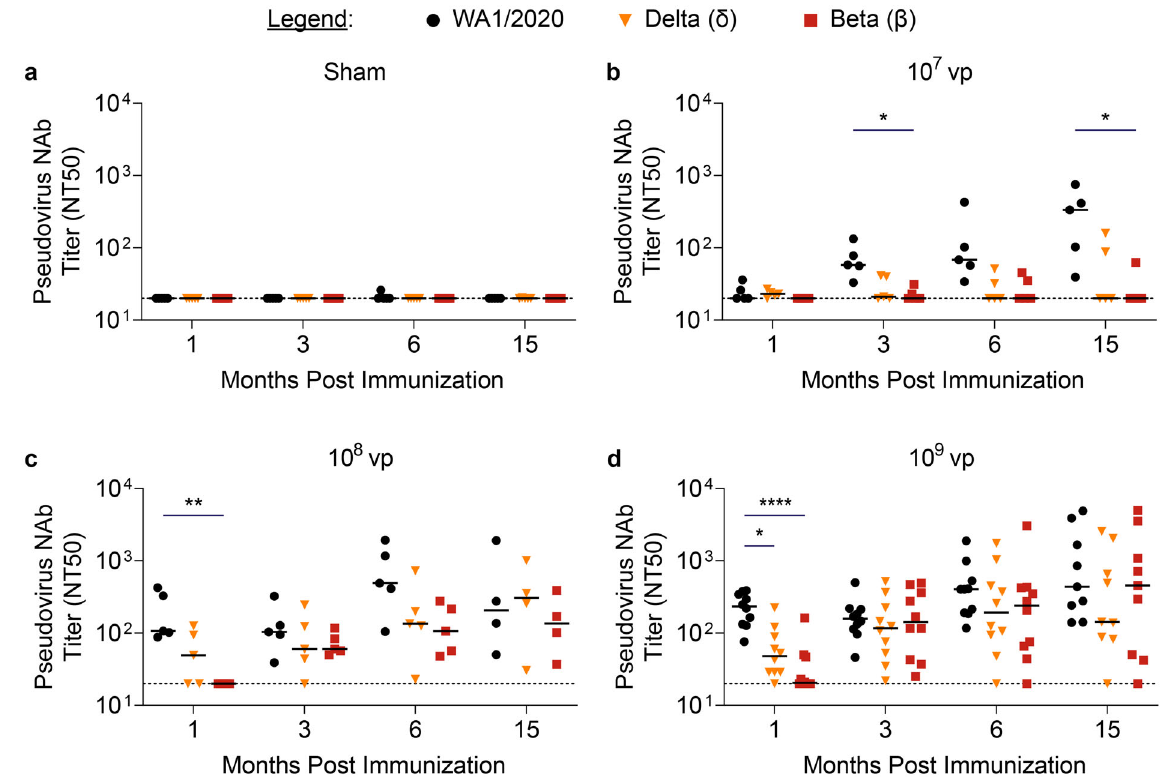
Fig. 3 Neutralizing antibody responses to variants expand in Ad26.COV2.S vaccinated mice. Neutralizing antibody (NAb) responses to pseudoviruses expressing WA1/2020 (black circles), delta (yellow triangles), or beta variant (red squares) SARS-CoV-2 spike protein were evaluated at months 1, 3, 6, and 15 postimmunization in ( a ) Sham-immunized ( N = 5) or ( b ) 1 × 10 7 vp ( N = 5) ( c ) 1 × 10 8 vp ( N = 5) and ( d ) 1 × 10 9 vp ( N = 10) Ad26.COV2.S immunized mice. Neutralizing responses are displayed as 50% neutralization titer (NT50). Horizontal bars re fl ect median NT50. Dotted lines re fl ect assay limit of quanti fi cation. P values re fl ect Kruskal Wallis tests with Dunn ’ s multiple comparisons, which were conducted separately for each dose and timepoint (* P < 0.05; ** P < 0.01; *** P < 0.001; **** P <